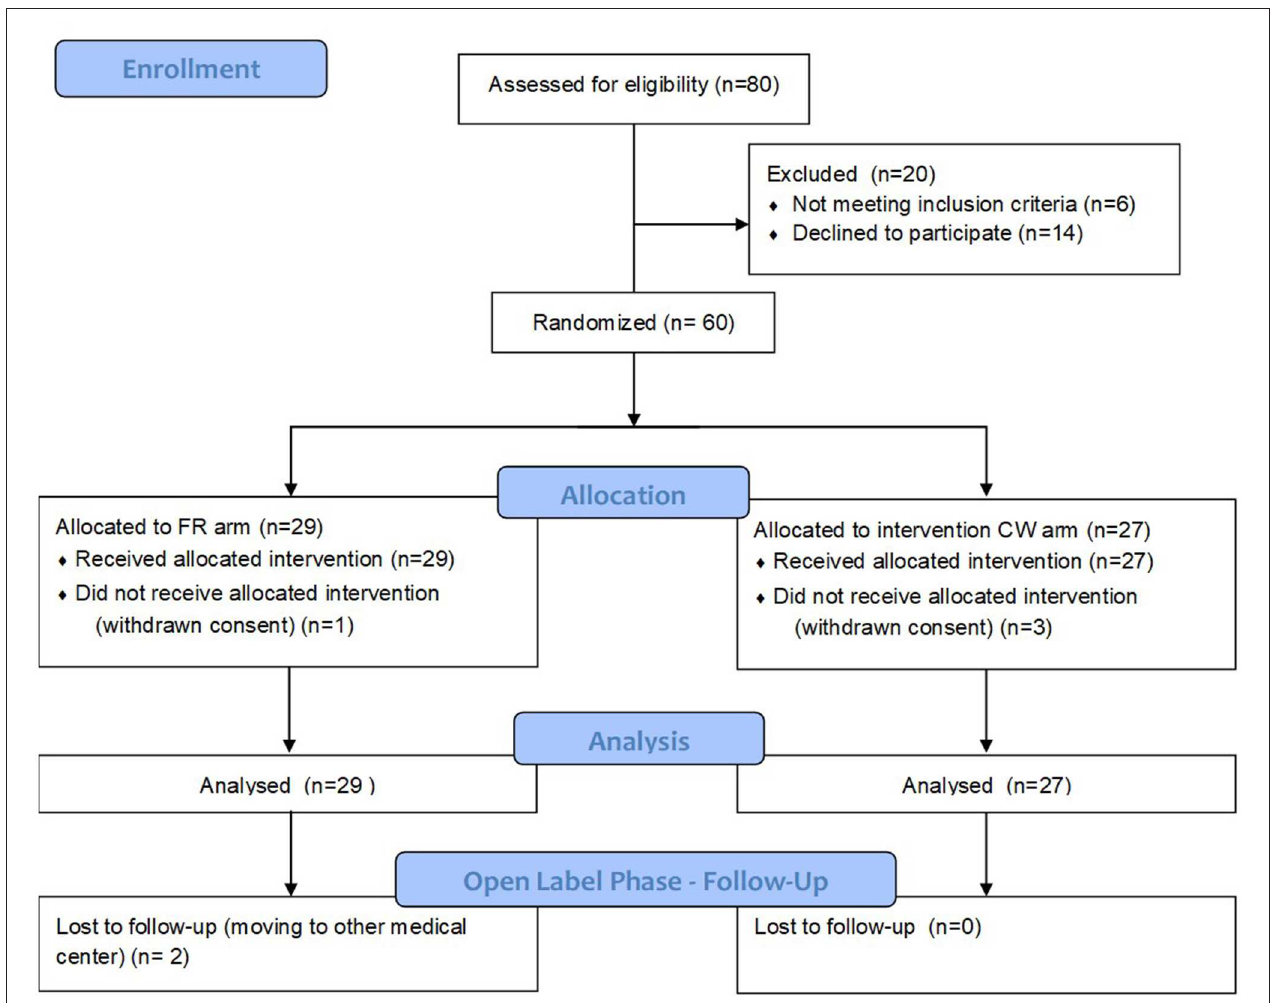
FIGURE 1 | CONSORT flow